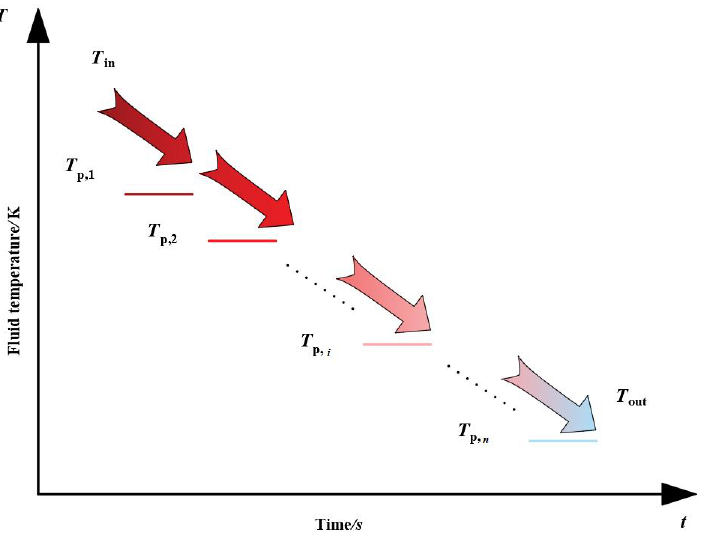
Figure 1. Fluid temperature variation in the cascaded phase change heat storage process.